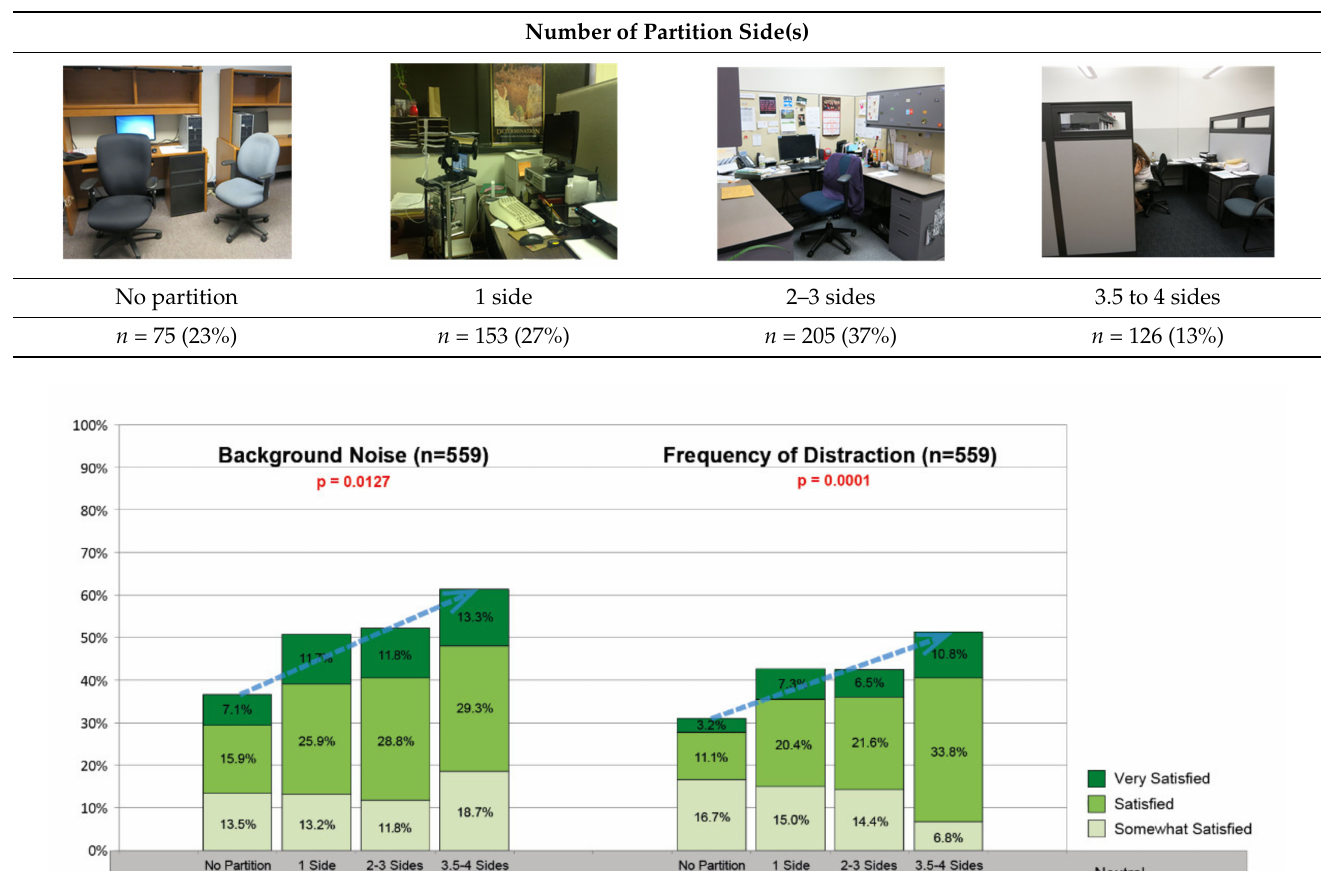
Table 12. Distribution in Partition Sides for 559 Questionnaire respondents in open-plan workstations.